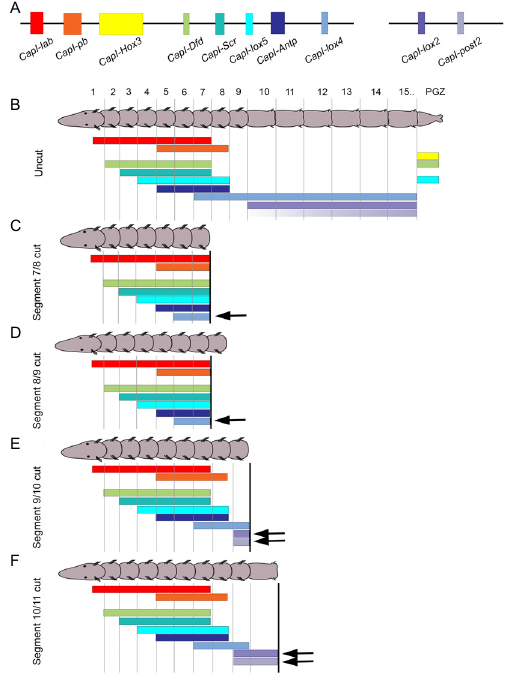
Figure 6. Effect of amputation location on Hox gene expression patterns. Schematic summarizing Hox gene expression patterns in uncut animals and animals amputated at different segmental positions. ( A ) Genomic organization of 10 of the Capitella Hox genes present in the Capitella genome [59]. Colored rectangles indicate position of coding sequence and black line indicates genomic linkage. ( B – F ) Schematics of animals with representation of Hox gene expression patterns. Anterior is to the left and the posterior growth zone (pgz) is indicated. Segment number is indicated above animal in B. Colored bars indicate position of Hox gene expression along the anterior–posterior axis. Color coding matches that of genes shown in ( A , B ). Uncut animals show staggered anterior Hox gene expression boundaries. ( C – F ) Depiction of expression boundaries 24 hours after amputation at specific segmental positions. Amputations were performed at the boundary between segments 7 and 8 ( C ), 8 and 9 ( D ), 9 and 10 ( E ) and 10 and 11 ( F ). Black arrows indicate examples of shifts in anterior gene expression boundaries in the anterior direction relative to expression boundaries in uncut animals. Adapted from